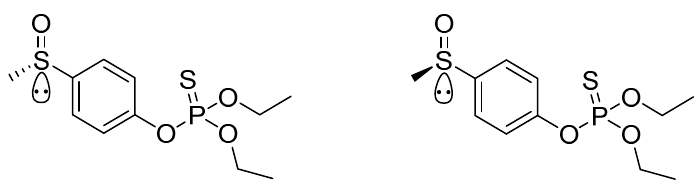
Figure 2. Chemical structure of fensulfothion enantiomers.